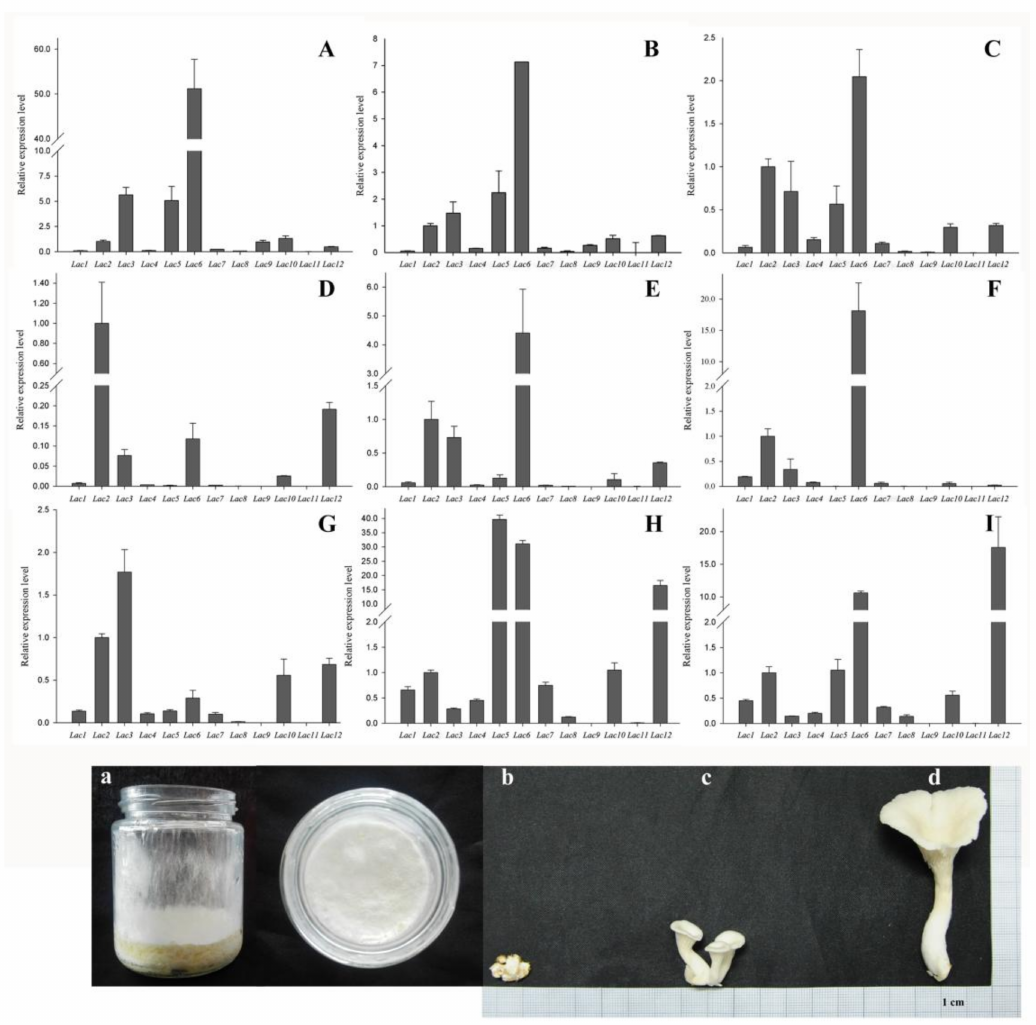
Figure 5. The relative expression of 12 PoLac genes at different developmental stages in the different culture medium. ( A – C ) the transcriptional profile of 12 laccase genes in the PDA medium during mycelium period (10 days, 20 days, and 30 days, respectively); ( D – F ) the transcriptional profile of 12 laccase genes in the solid medium of cotton-straw during mycelium period (10 days, 20 days, and 30 days, respectively); ( G – I ) the transcriptional profile of 12 laccase genes of primordium, juvenile, and maturation mushroom under cotton straw culture, respectively. Values are means of three replicates ± SD. And the figure correspondingly shows the samples from different growth stages of P. ostreatus . ( a ) the mycelium sample; ( b ) the primordium sample; ( c , d ) fruiting body under two growth stages (young and maturation),